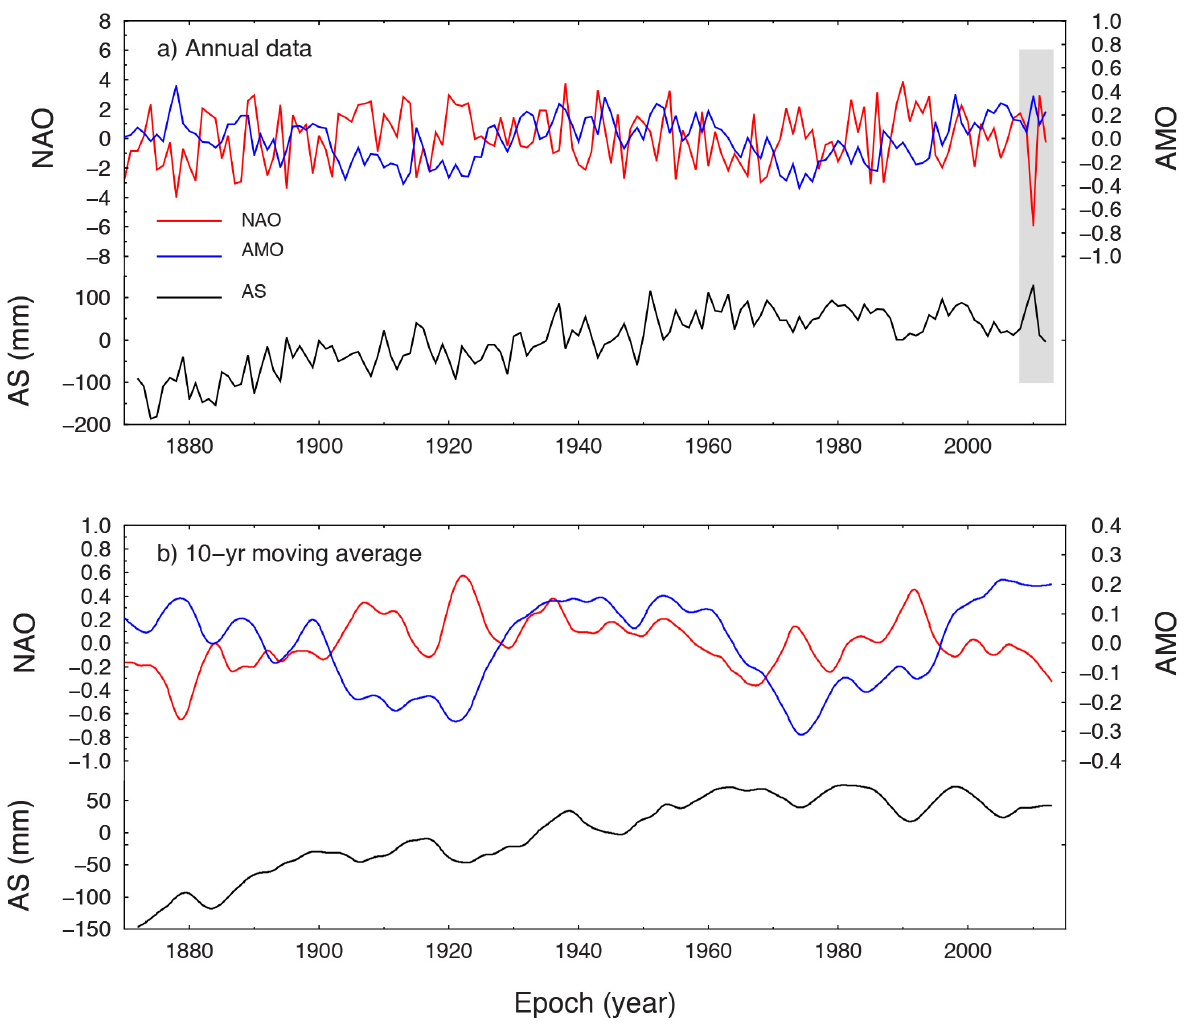
Figure 5. Comparison between NAO (red line), AMO (blue) and sea–level stack for the Adriatic tide gauges (AS, black). Frame (a) shows annual data for the three time series; while (b) shows their 10-years moving average. The 2010-2011 anomaly is marked by a shaded rectangle in